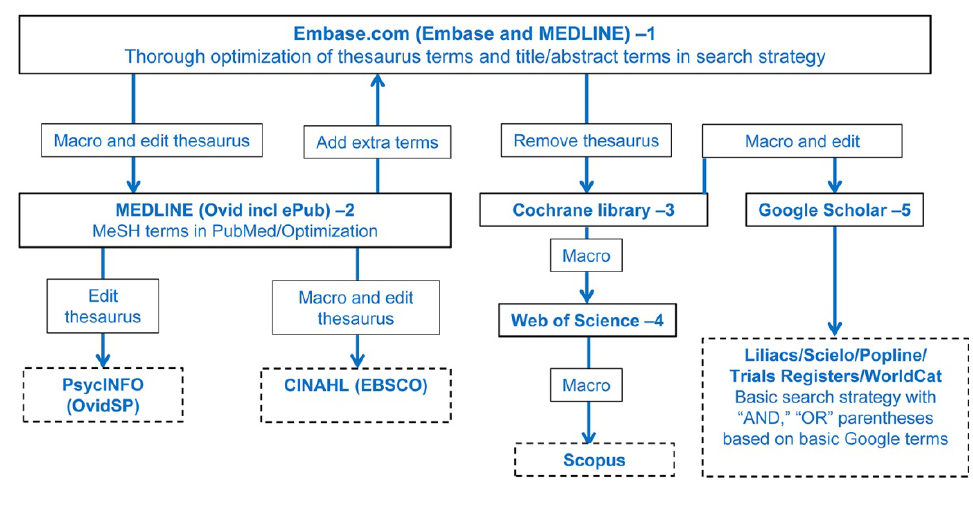
Dotted lines represent databases that are used in less than 80% of the